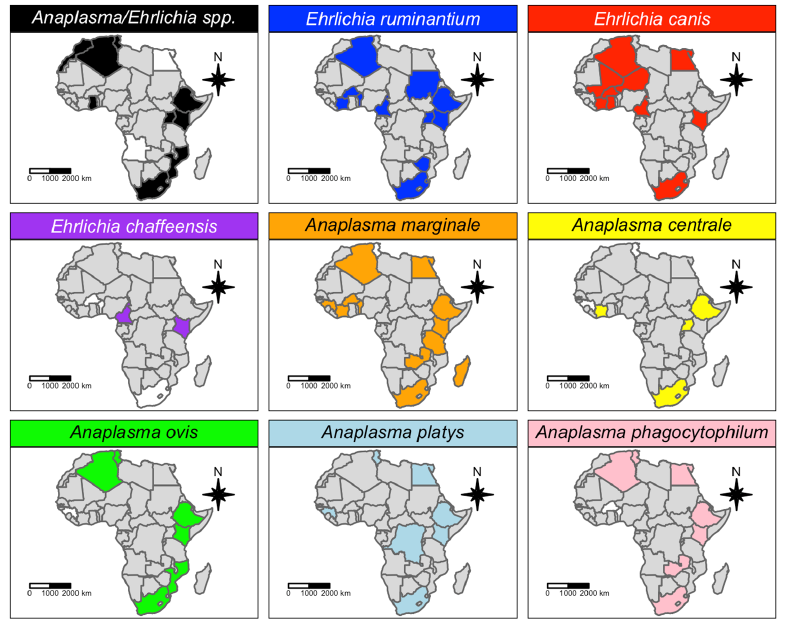
Figure 4. Geographic distribution of Anaplasmataceae species detected in African ticks. Countries where the pathogen was investigated, but not detected, are represented in white, while countries where the pathogen has not been investigated are represented in grey.